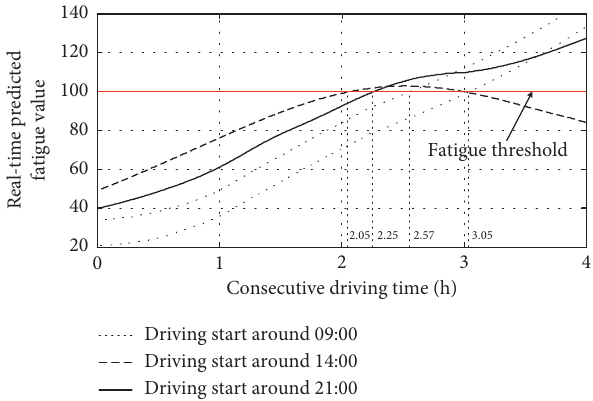
Figure 13: Maximum driving time below the fatigue